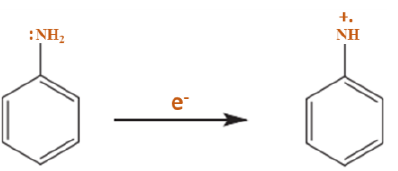
Figure 6. Structure of radical cation of aniline. Reproduced with permission from J. Electroanal. Chem.,Vol 236 Genies, E.M.; Lapkowski, M. Spectroelectrochemical evidence for an intermediate in